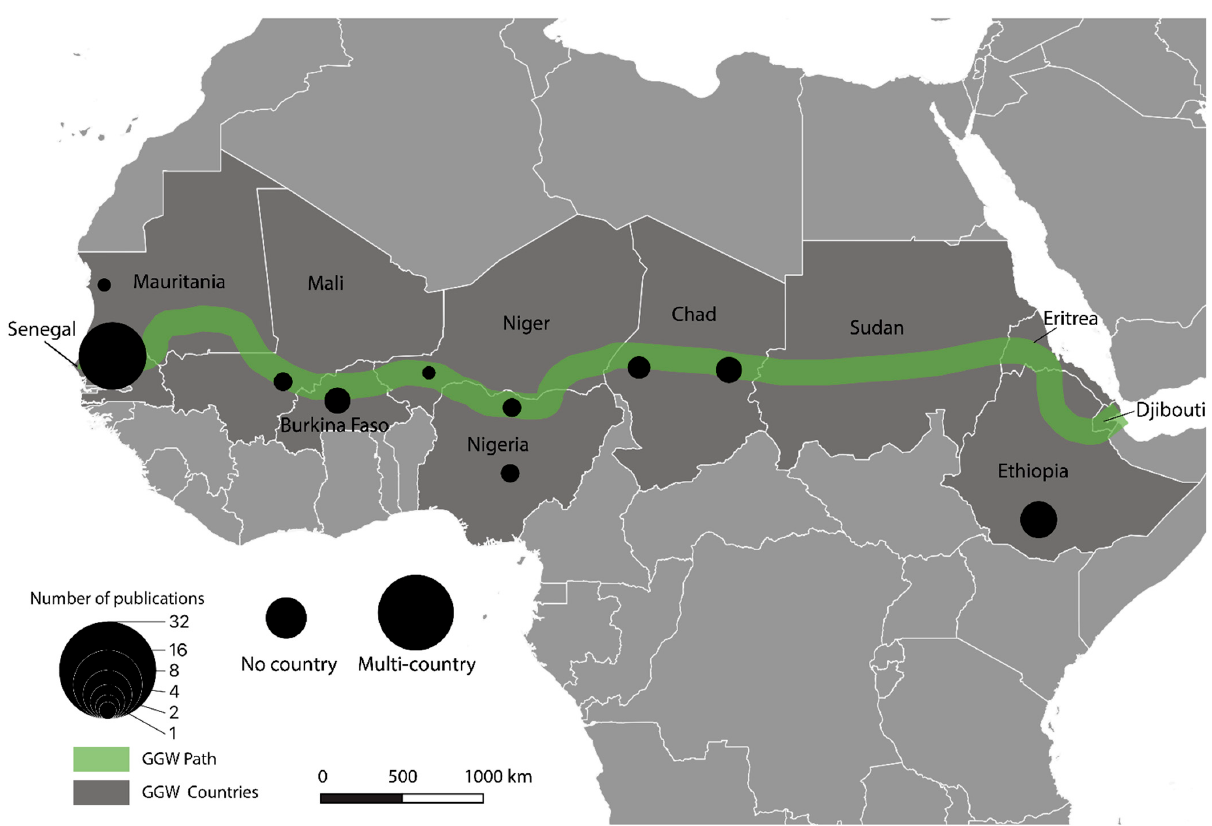
Figure 2. Map displaying the number of publications collected by region using the keyword GGW in WoS, Science Direct, HAL and Agritrop databases (n =